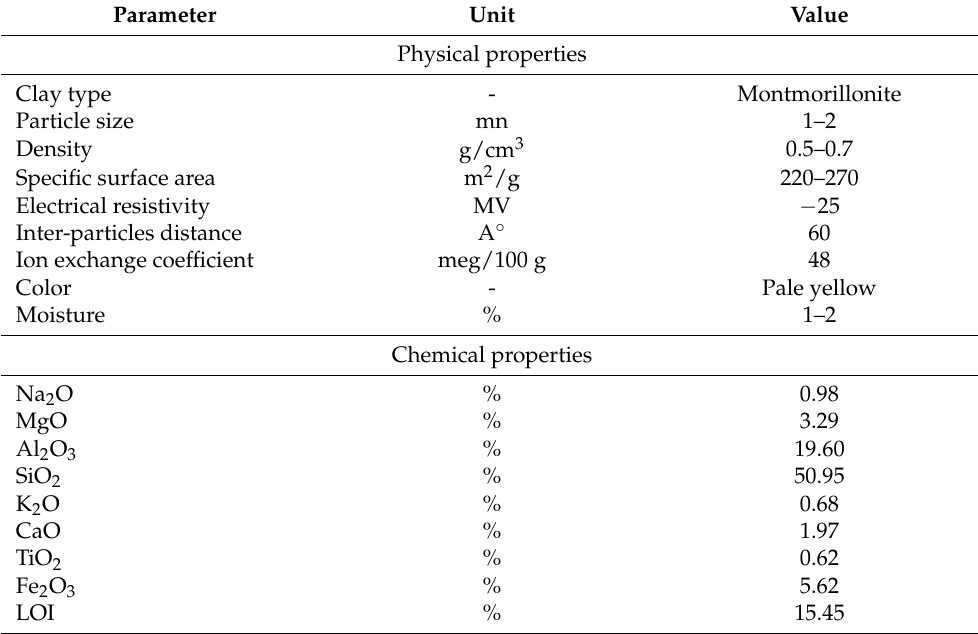
Table 2. Physical-chemical properties of the nano montmorillonite.